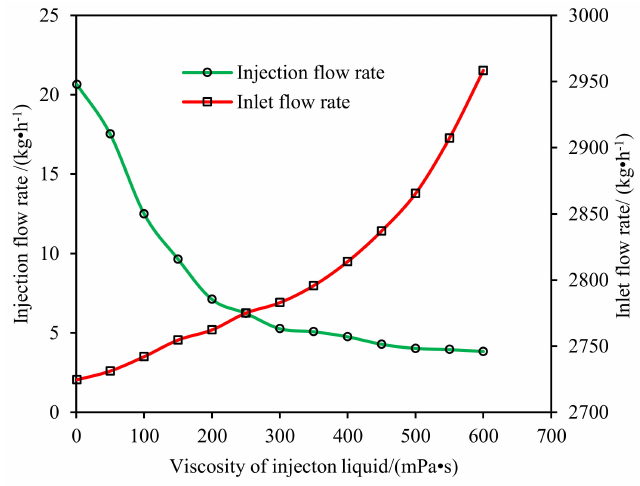
Figure 6. Influence of viscosity of injection liquid on Q il and Q ij